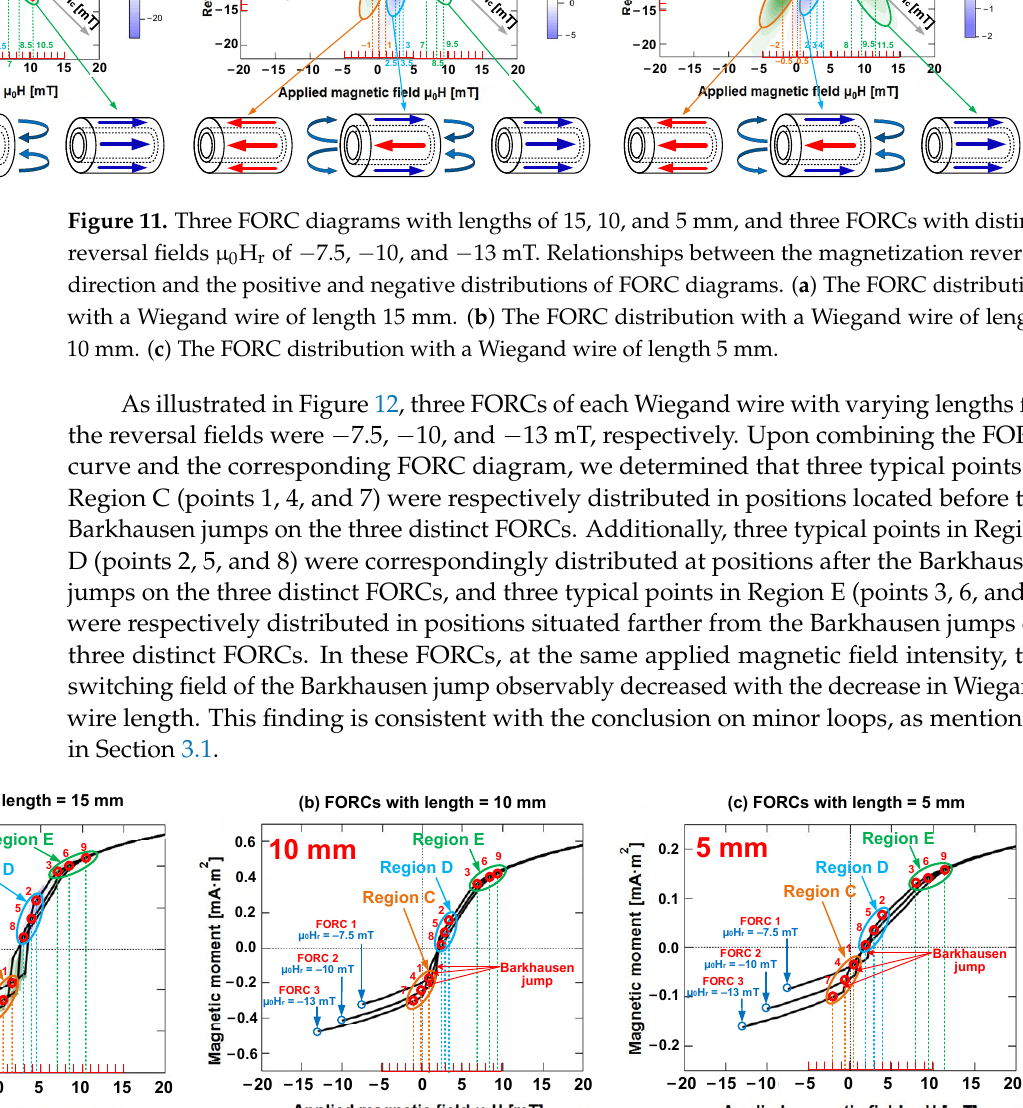
Figure 12. Three FORCs of each Wiegand wire with varying lengths if the reversal fields are − 7.5 mT,